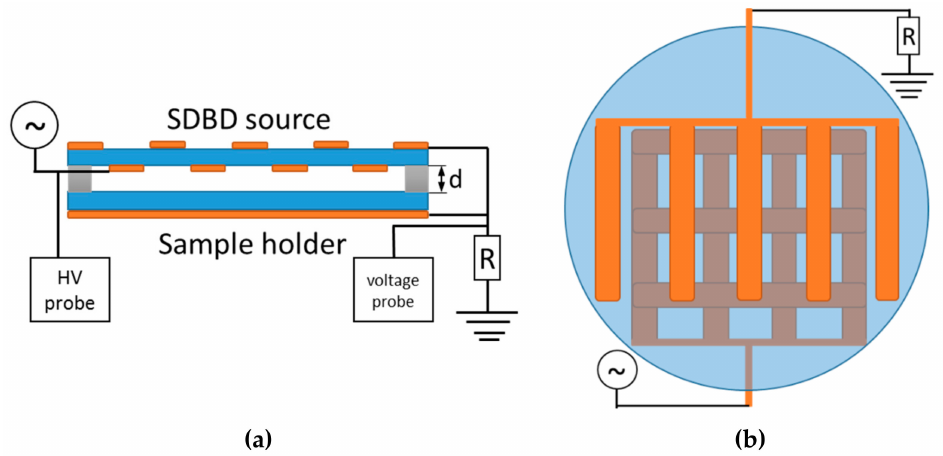
Figure 11. SDBD source schematics: ( a ) side view of the setup and schematics of electrical circuit; ( b ) top view of an upper electrode part. Dimensions of the source are given in the